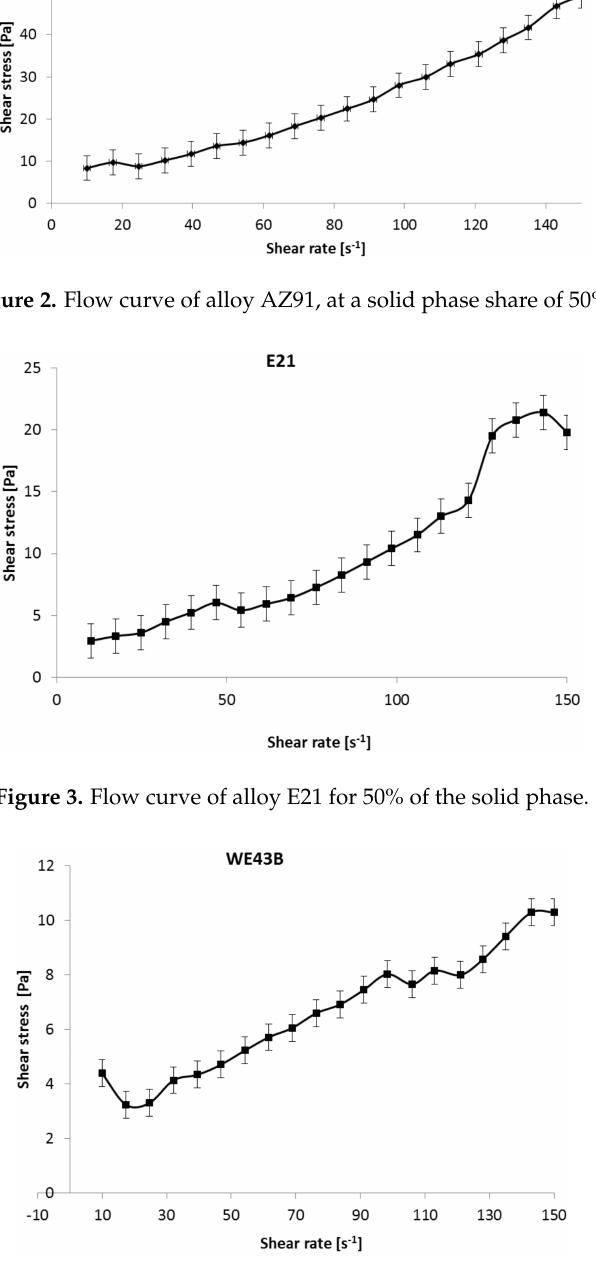
Figure 4. Flow curve of alloy WE43B for 50% of the solid